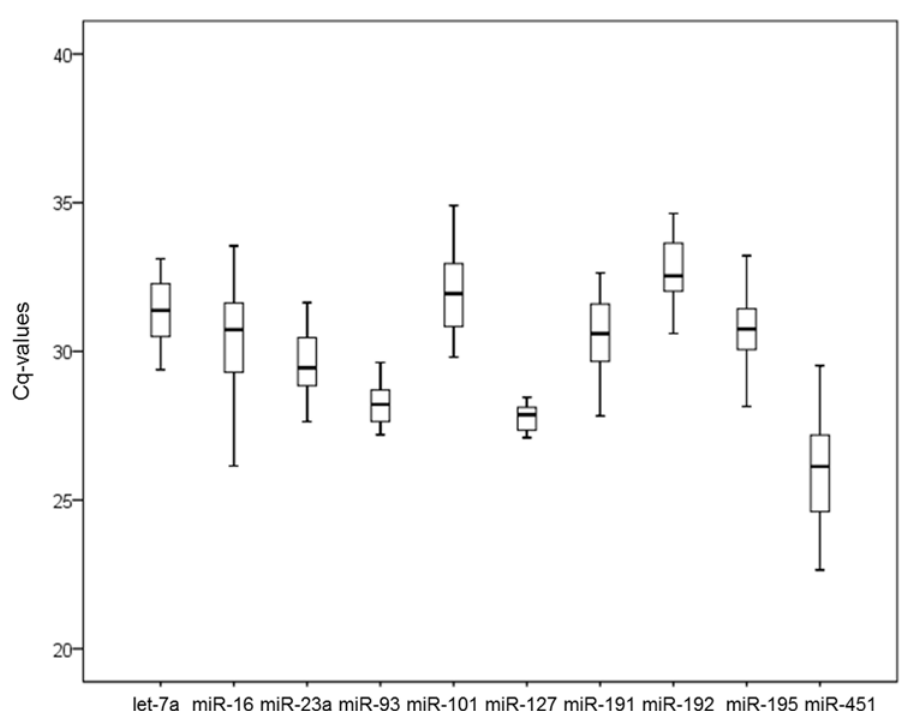
Fig 1. Expression levels of candidate reference miRNAs in bovine serum. The expression levels of ten candidate miRNAs were validated in bovine serum. Box plots of raw Cq values were produced. Boxes represent the lower and upper quartiles with median (n = 34). Values are given as real-time PCR cycle threshold numbers. Box and whisker plot displaying the range of Cq values for each putative reference miRNA. The median is marked by the middle line in the box. The boxes represent the 25th and 75th percentiles, and ranges are represented by the